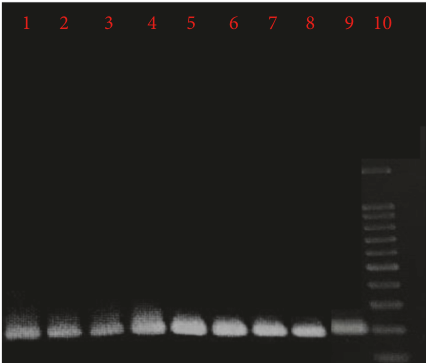
Figure 1: Agarose gel electrophoresis of PCR product of ITS-2 gene of L. infantum from buffy coats of healthy children. Lanes 1 to 8: samples isolated from the buffy coat of children. Lane 9: positive control (L. infantum) . Lane 10: molecular